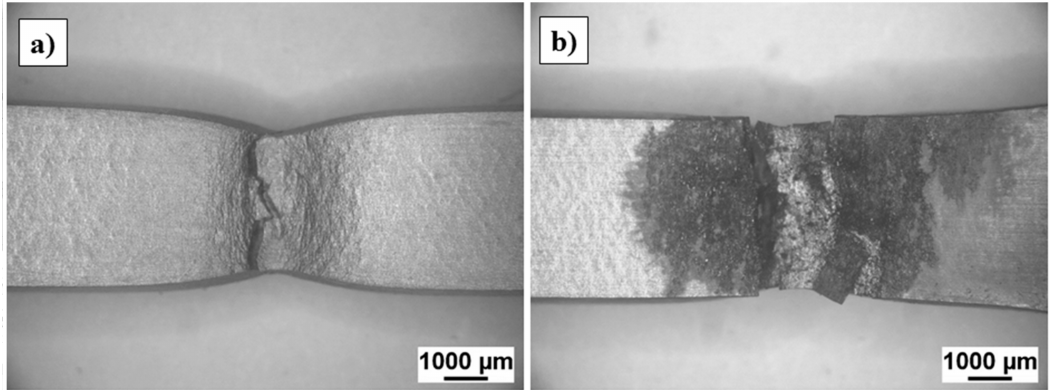
Figure 3. Macrograph acquired on the gauge length of DSS 2304 sample after SSRT in 20% NaCl solution at 80 ◦ C, in the absence ( a ) and in the presence of 10 − 2 M S 2 O 3 2 − ( b